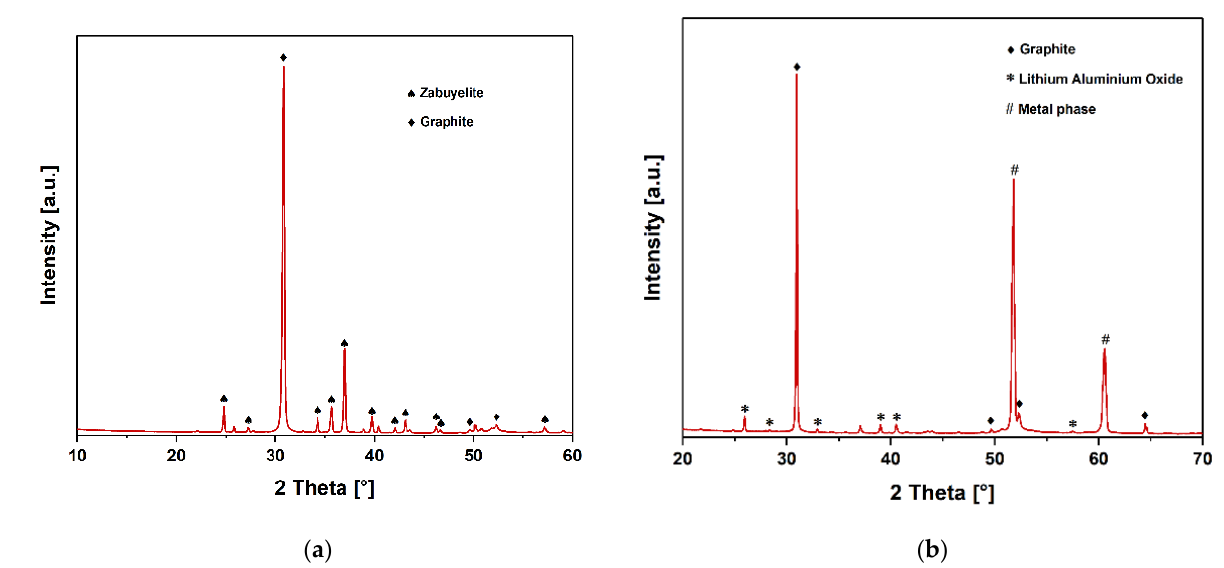
Figure 7. PXRD pattern: ( a ) results of sparse magnetic powder; ( b ) results of powder.